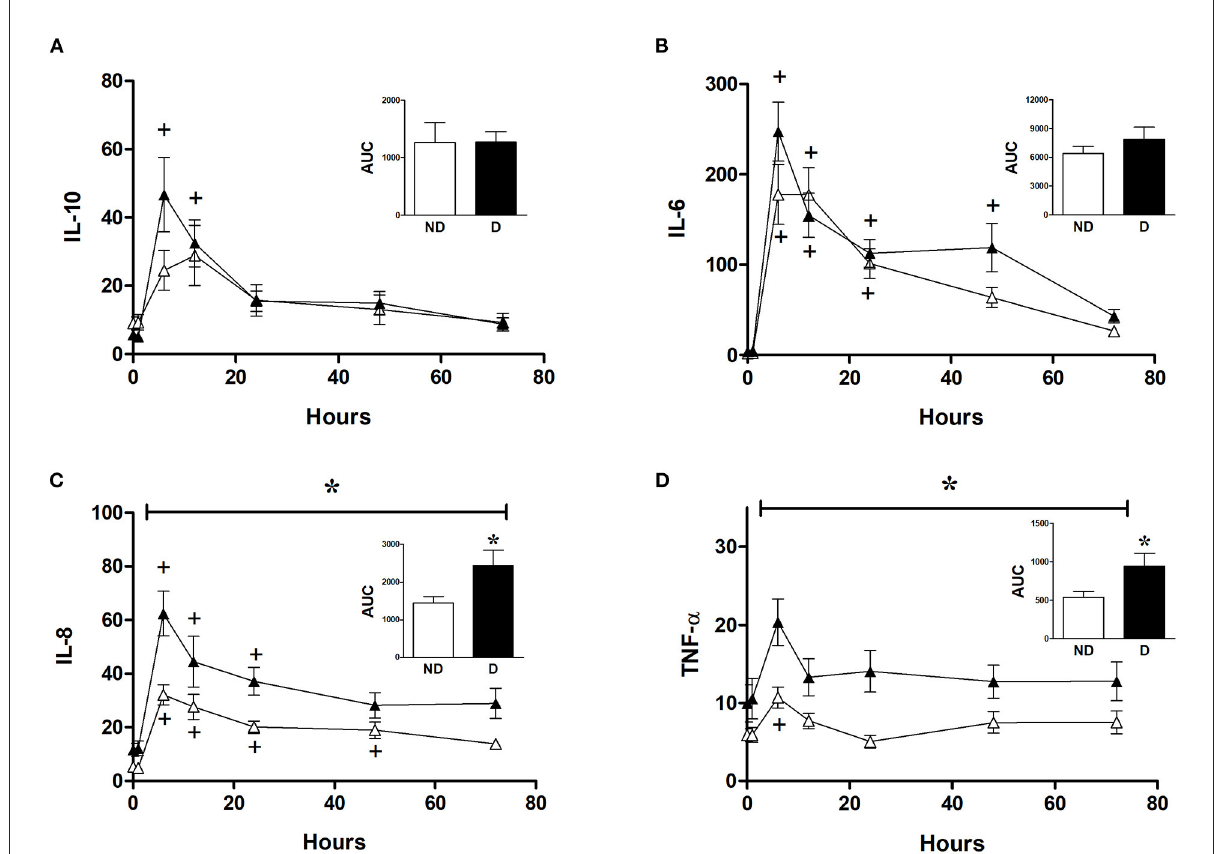
FIGURE6 Effect of diabetes on postoperative changes in inflammatory markers. Values (pg/ml) are mean ± SEM for levels of IL-10 (A) , IL-6 (B) , IL-8 (C) , and TNF- α (D) , in patients undergoing CABG surgery who are non-diabetic (ND, white, n = 12) or diabetic (D, black, n = 12). Analysis by two-way mixed model ANOVA did not reveal any significant differences for (A) or (B) , whilst the horizontal bracket in (C) and (D) represents a significant “between subjects effect” over all timepoints. One-way ANOVAs with post-hoc Dunnett’s test were appropriate were also performed individually for non-diabetic and diabetic patients; + represents a significant difference compared to basal levels. AUC (area under the curve) was analyzed using unpaired two-tailed student’s t -test or Mann-Whitney U -test as appropriate; * Represents a significant difference between